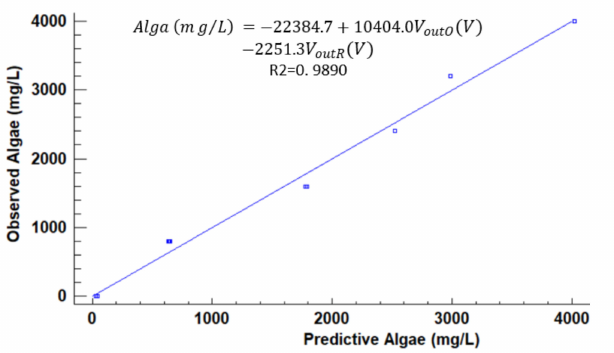
Figure 18. Observed vs. predicted values of algae concentration with a solid concentration of 4000 mg/L.